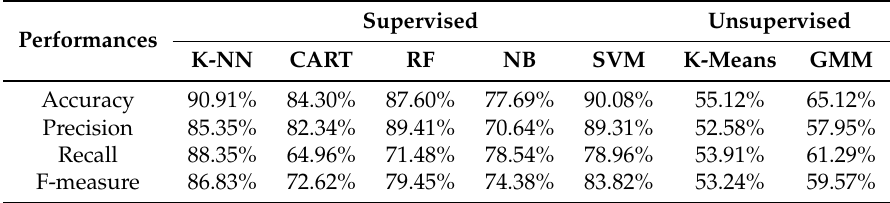
Table 6. Accuracy, Precision, Recall and F-measure for each classifier in the case of the Hausdorff et al. sub-dataset.